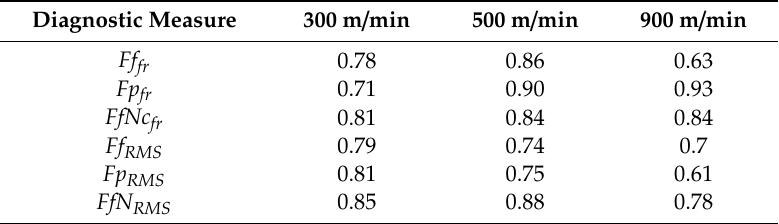
Table 10. Values of coefficient R 2 based on cutting forces .